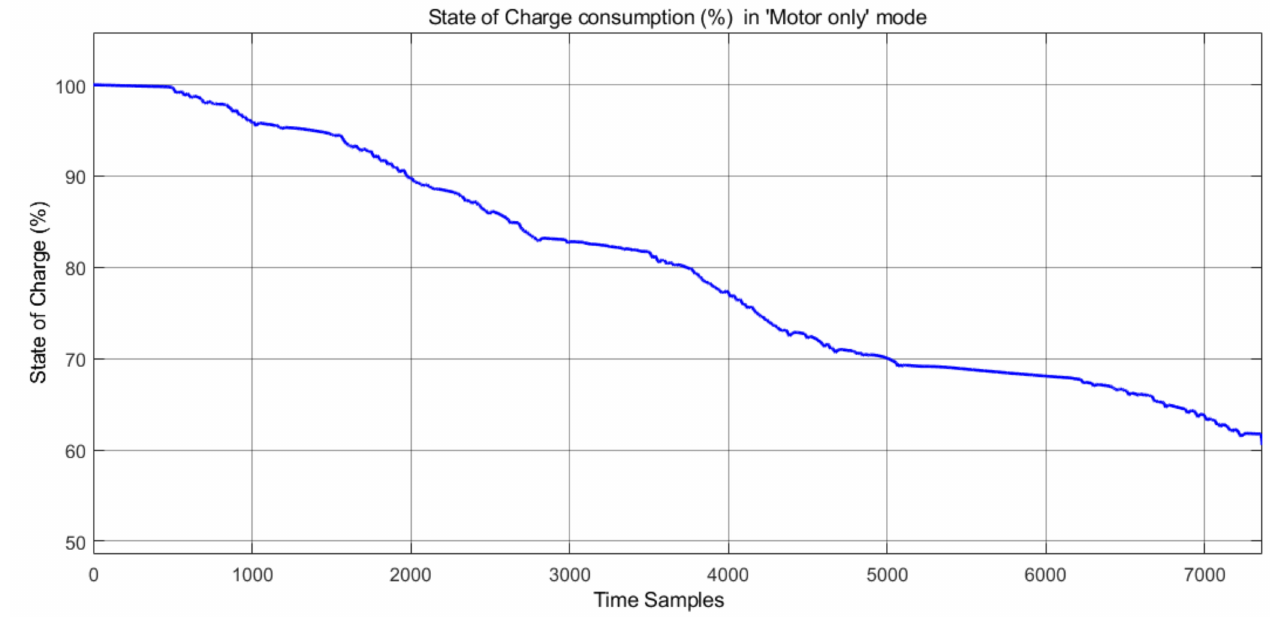
Figure 15. Simulation results for fuel consumption during HEV mode.